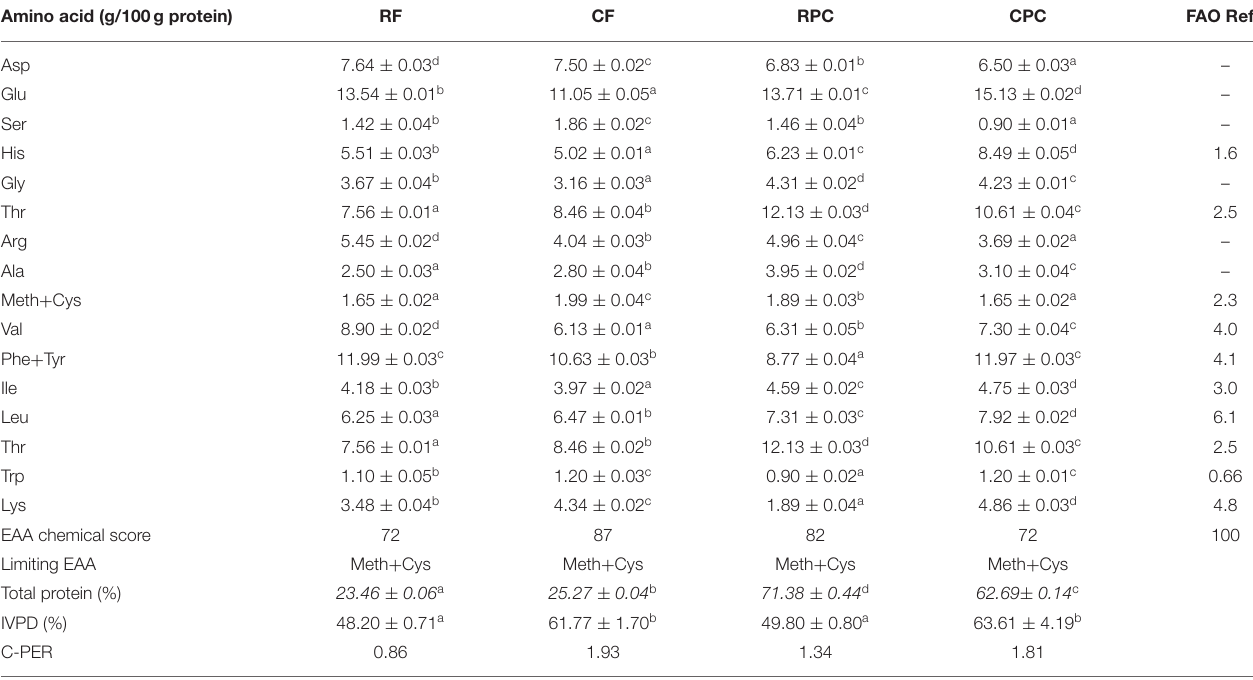
TABLE 5 | Amino acid composition and nutritional evaluation of tepary bean flours (RF and CF) and protein concentrates (RPC and CPC). Amino acid (g/100g